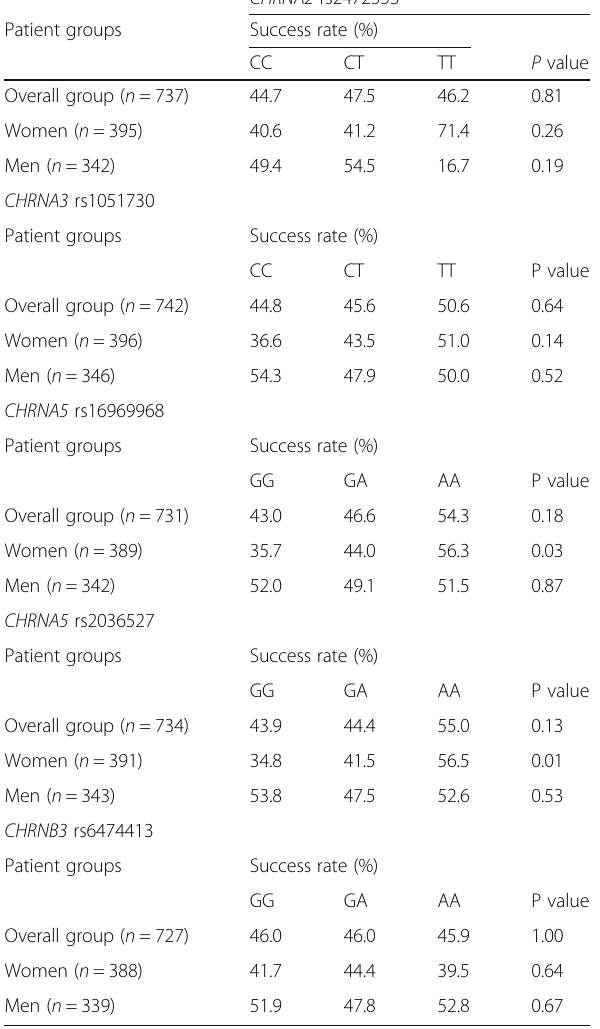
Table 3 Multivariate logistic regression analysis for success